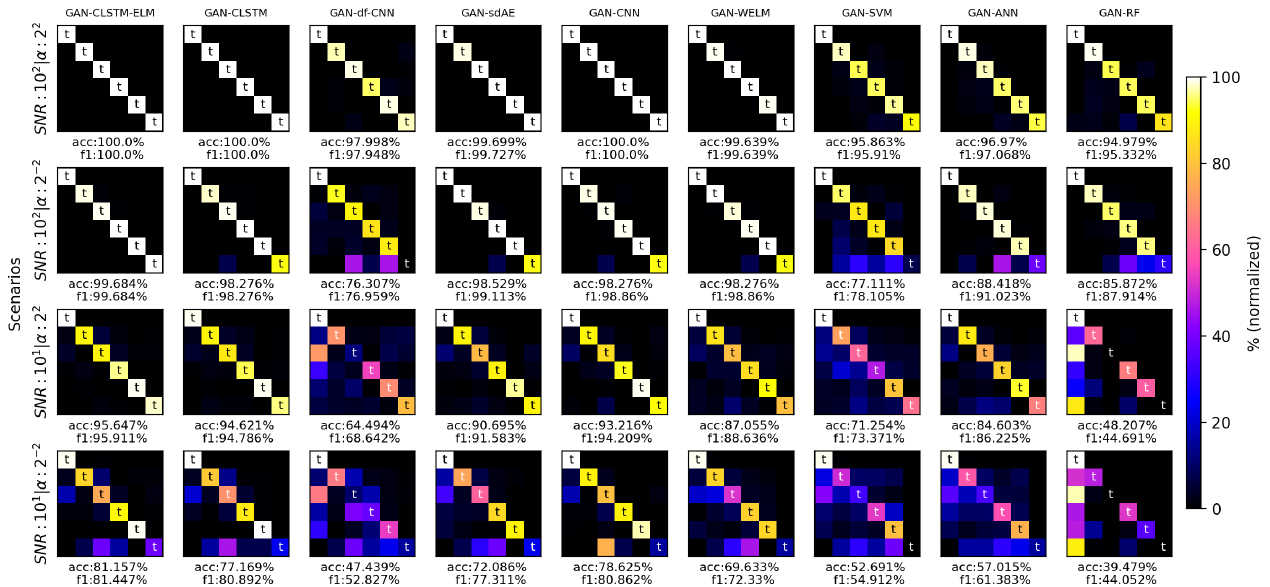
Figure 14. Confusion matrices and f 1 -scores of the comparison panel with WGAN-GP augmentation in different scenarios (t represents true labeled